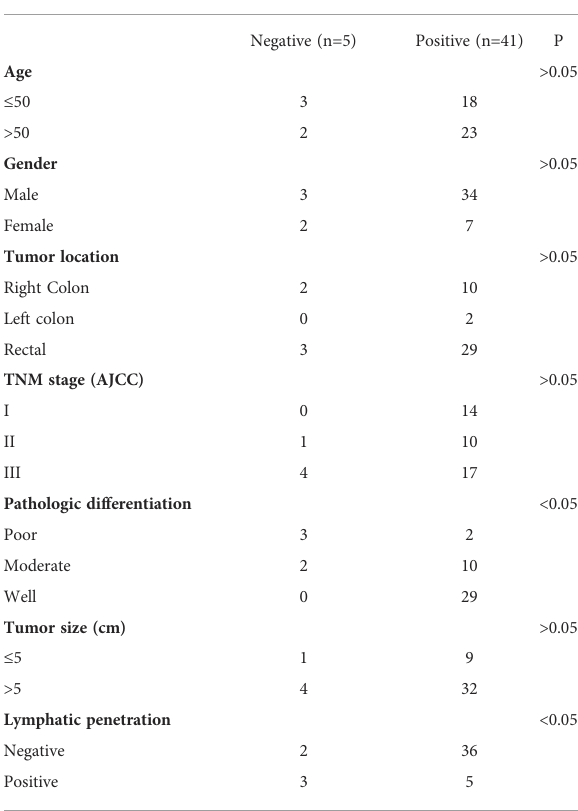
TABLE 2 Clinicopathologic characteristics and ARID1A expression in patient samples of colorectal cancer.